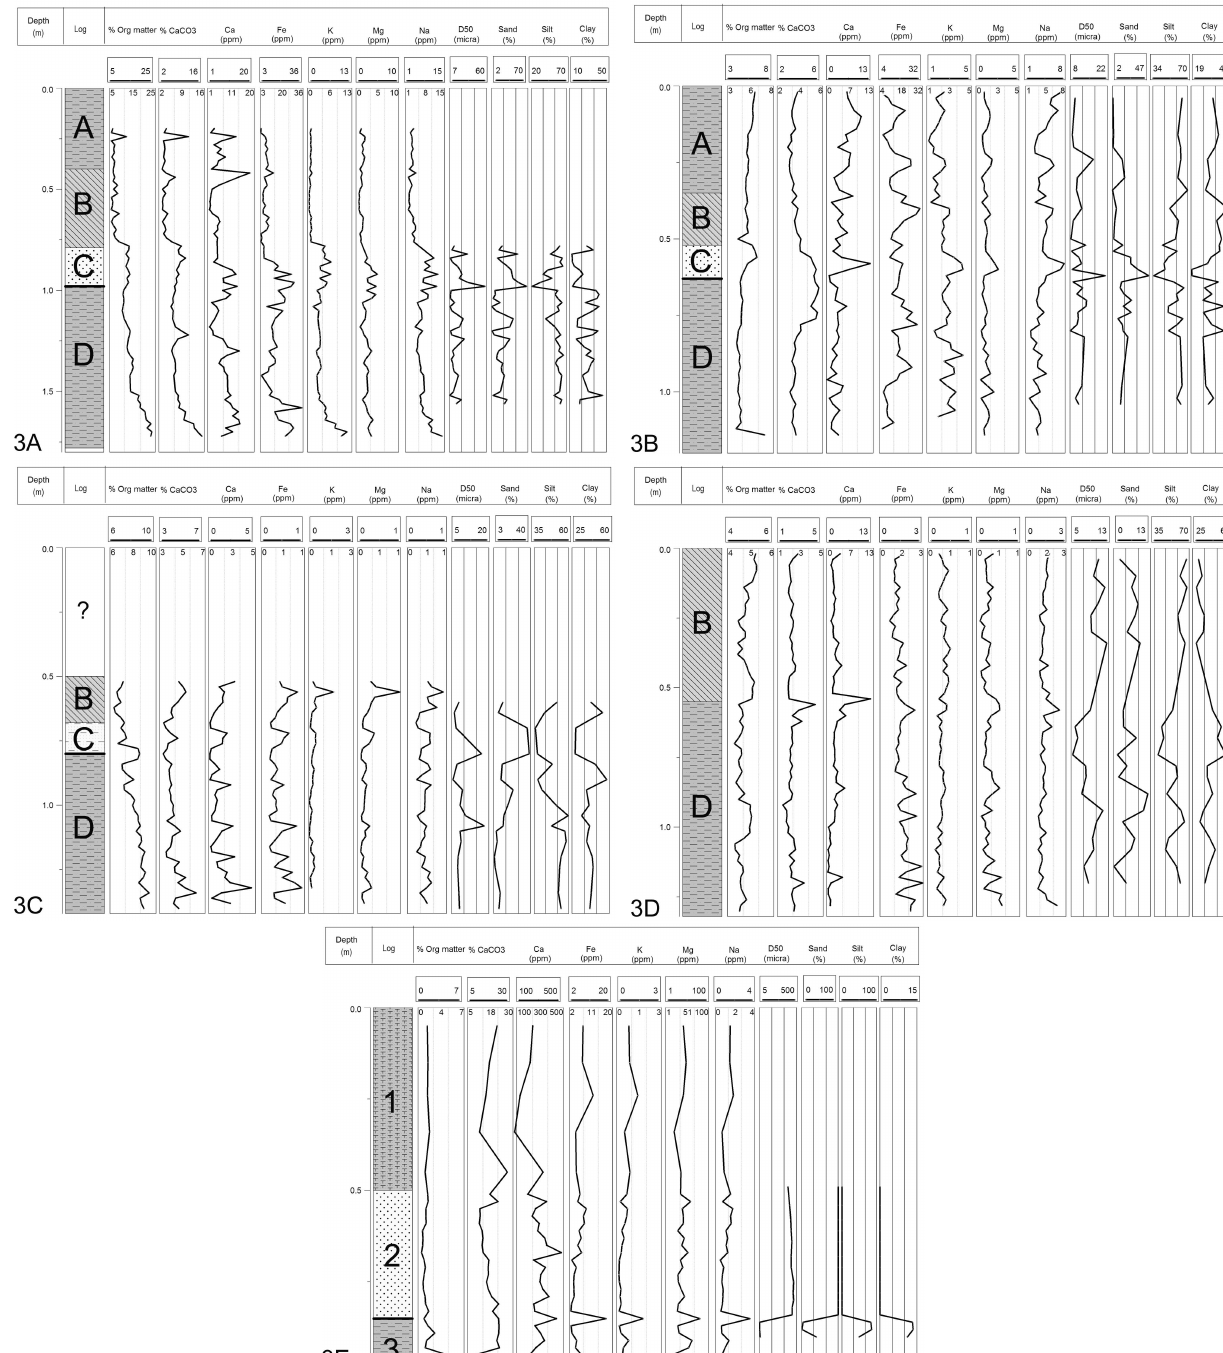
Fig. 3. Geochemical and grain-size results from sediment cores obtained in Lagoa de ´ Obidos and Martinhal. (a) results from core OB1. (b) results from core OB4. (c) results from core OB5. (d) results from core OB2. (e) results from core 27 Mart. Please note different range of values for each core and proxy. For core locations please check Fig. 1d and